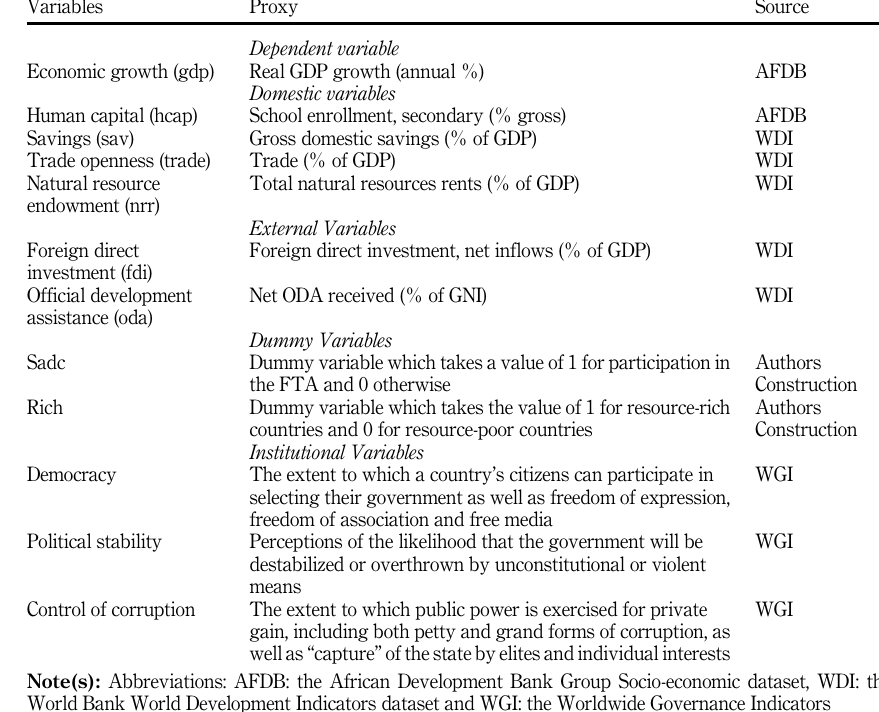
Table 1. Variable definitions and